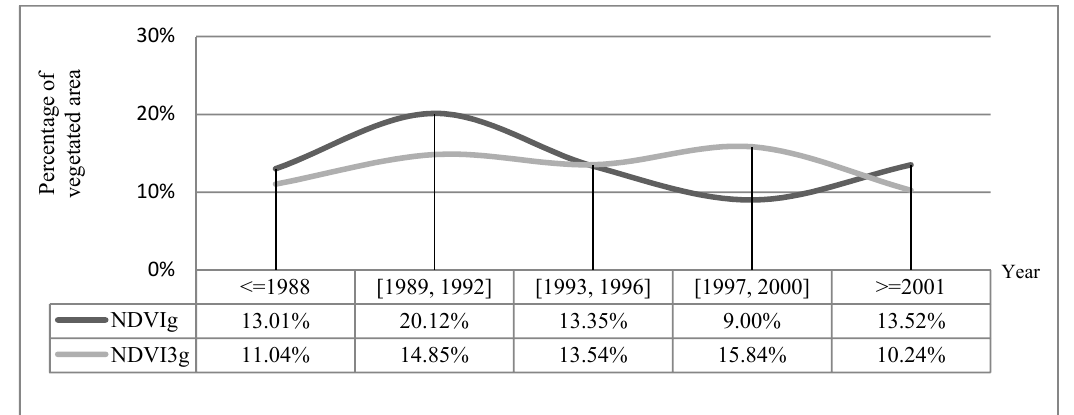
Figure 6. Frequency distribution for the turning point (TP) in the growing-season NDVI derived from different NDVI data sets.